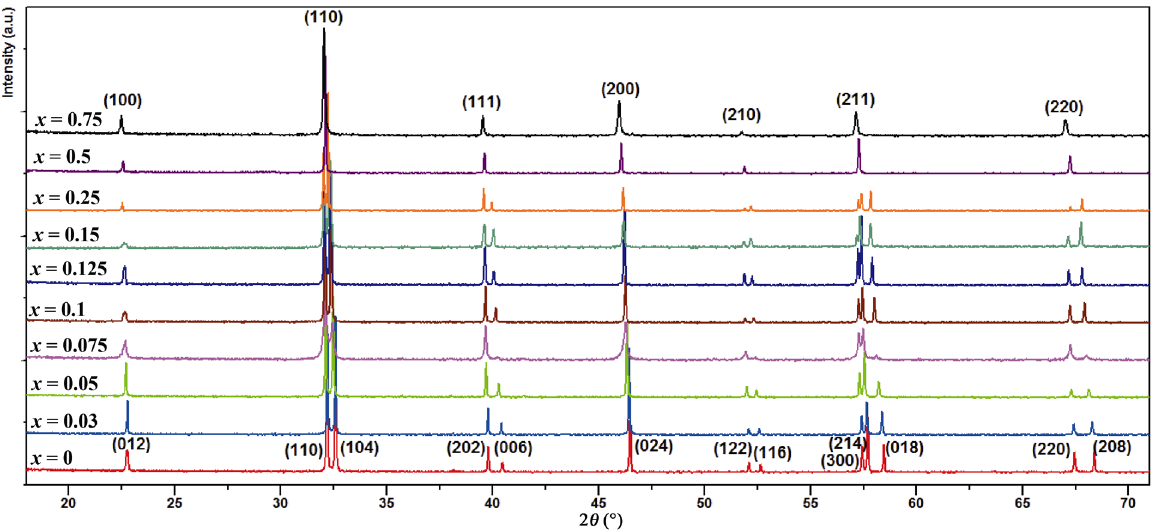
Fig. 1 XRD patterns of the La 1 − x Ba x CoO 3 solid solution at room temperature with 0 ≤ x ≤ 0.75.